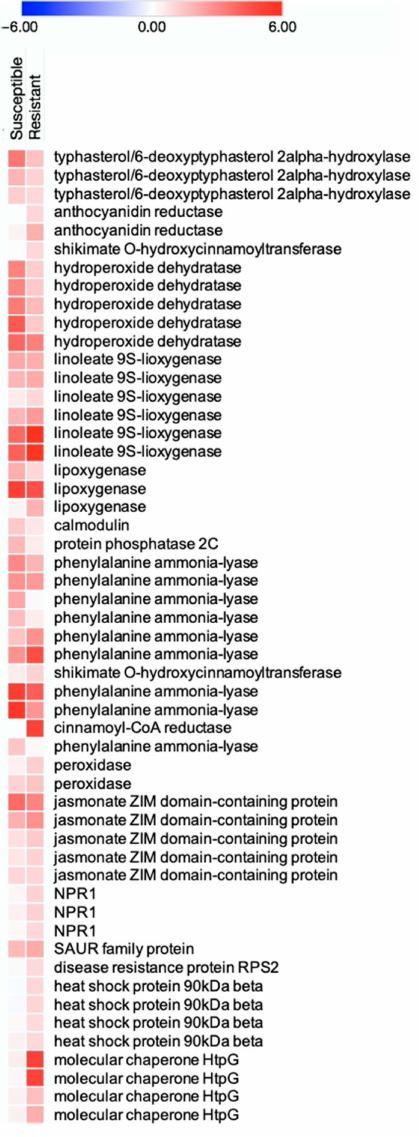
Figure 5. Heat map of DEGs in the resistant and susceptible wheat exposed to wheat curl mites. The heat map shows DEGs across the resistant and susceptible wheat that were mapped to several defense-related pathways. The color key represents log2-transformed fold changes, and the red bars indicate increases in expression in response to wheat curl mite